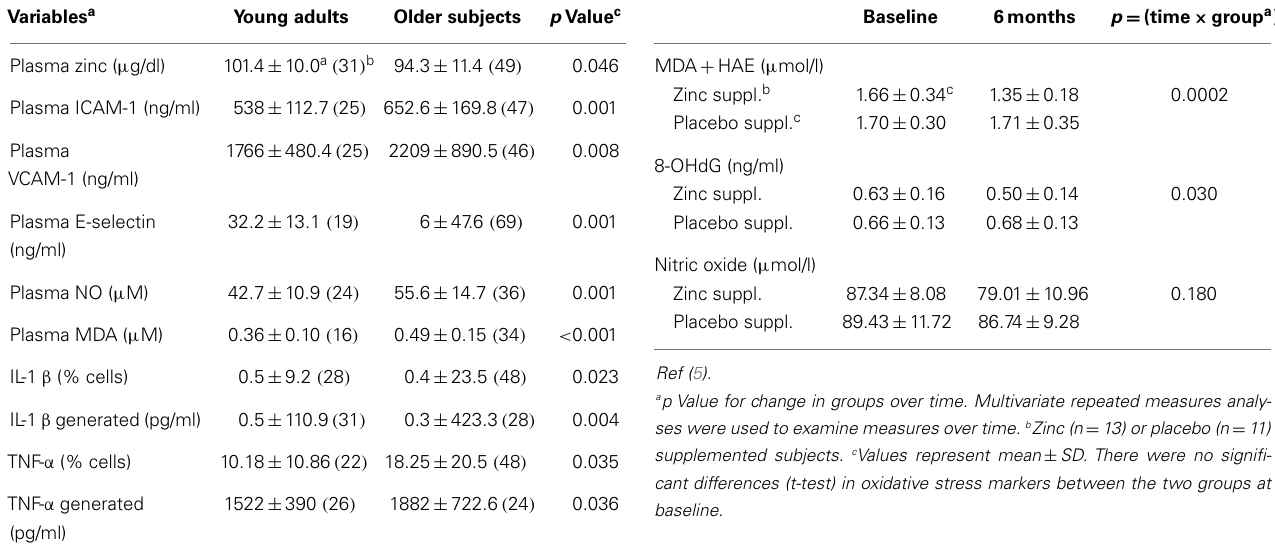
Table 4 | Effect of zinc and placebo supplementation on interleukin (IL)2 mRNA and plasma zinc concentration in zinc-deficient elderly subjects